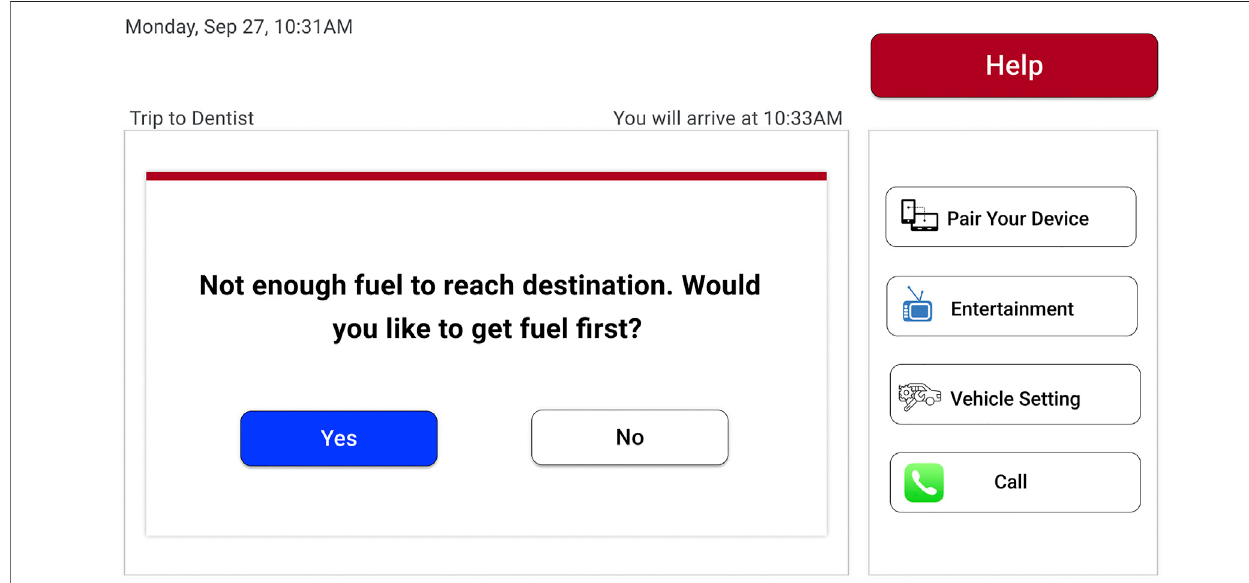
FIGURE 4 | Prototype of the refuel/recharge the vehicle